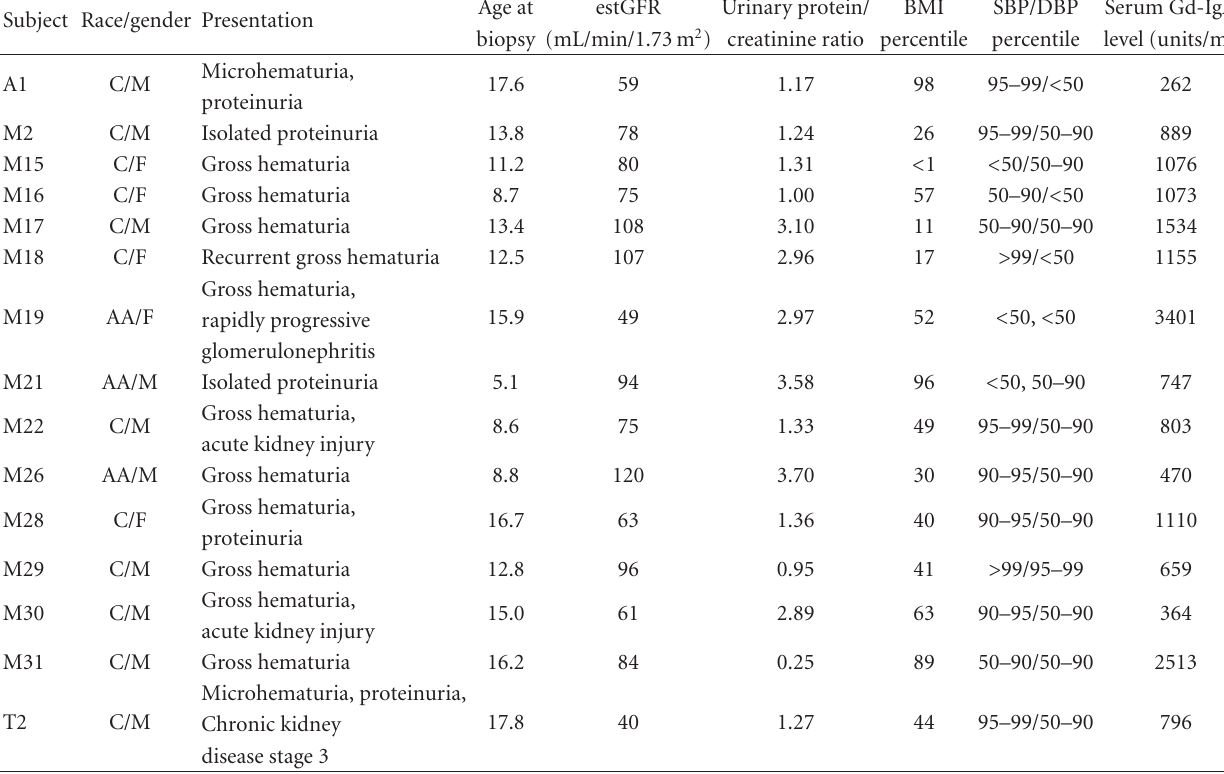
Table 1: Clinical and demographic features of individual subjects (incident